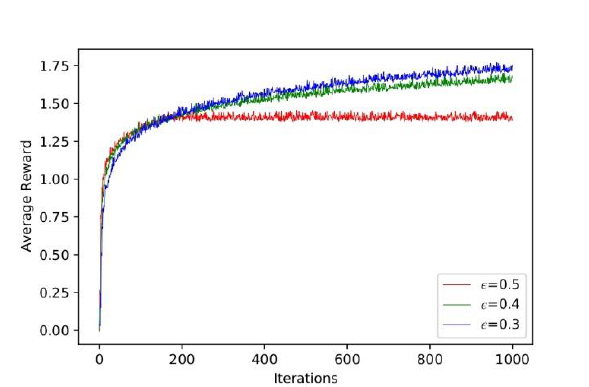
Figure 8. The average reward with the different exploration rates 𝜖